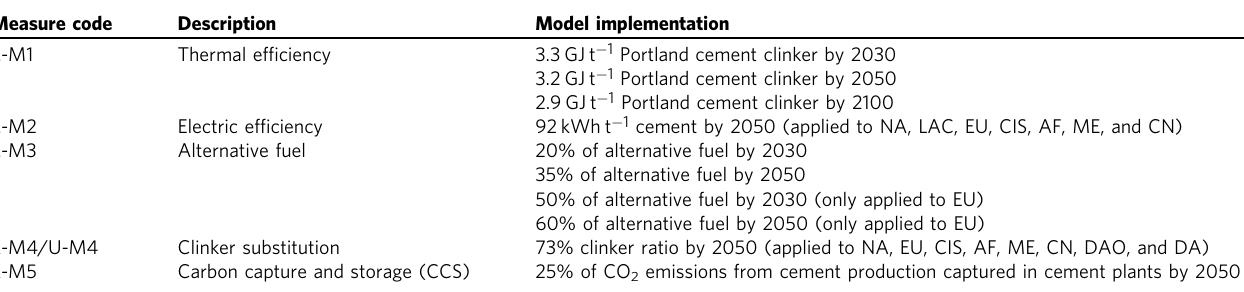
Table 1 Supply-side mitigation measures and their